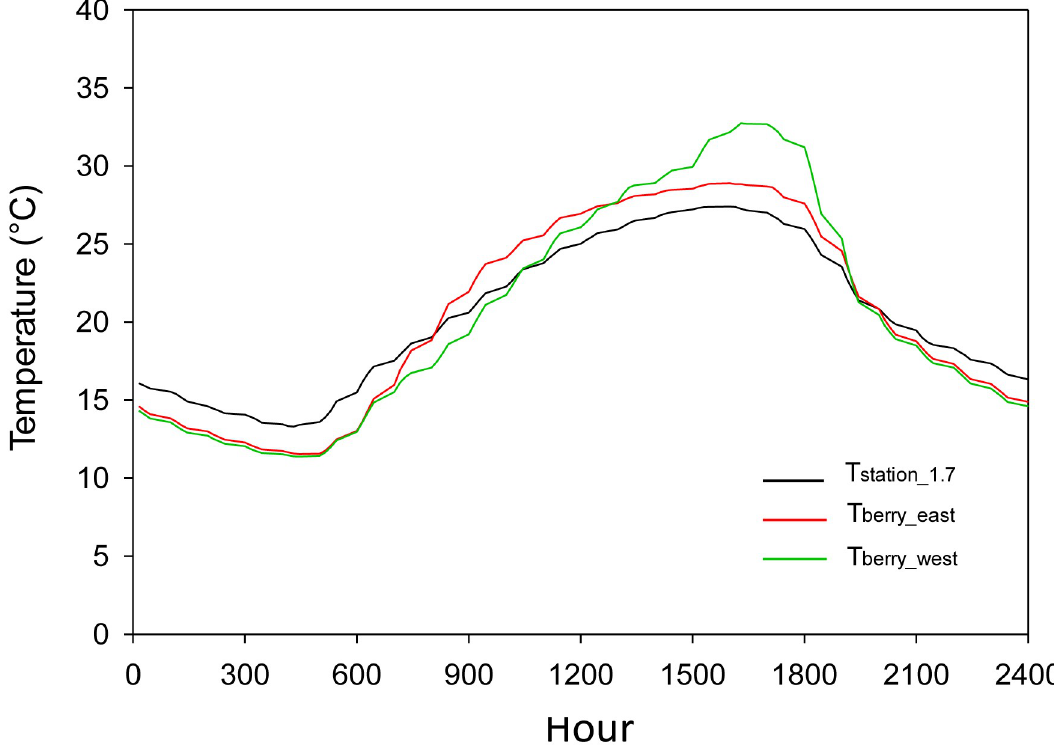
Fig 9. Typical daily profile of air temperature, based on 15-min data, of the ambient in the clusters facing east (T berry_east ) and west (T berry_west ) and at the weather station (T station_1.7